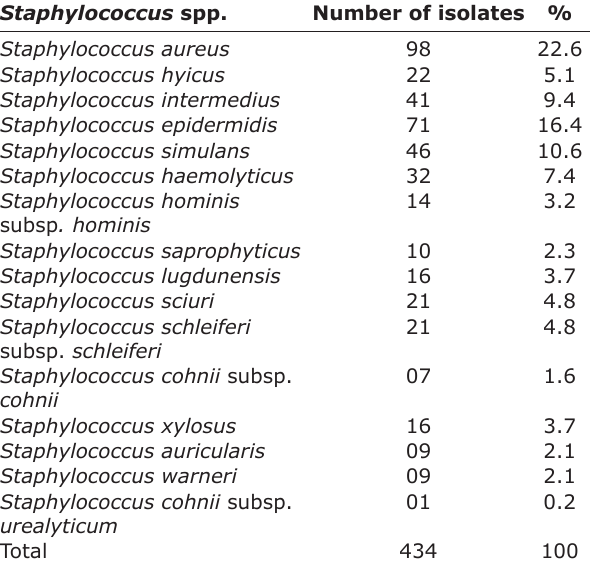
Table-1: Coagulase-positive Staphylococcus and coagulase-negative Staphylococcus spp. cultured from raw goat milk from Northeast Brazil. Staphylococcus spp.